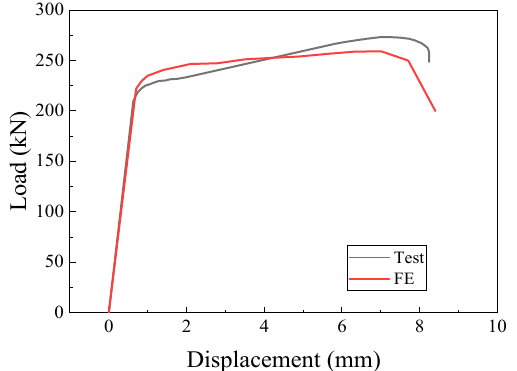
Figure 15. Load-displacement curves of the bolt-sphere connection from the test and FE.